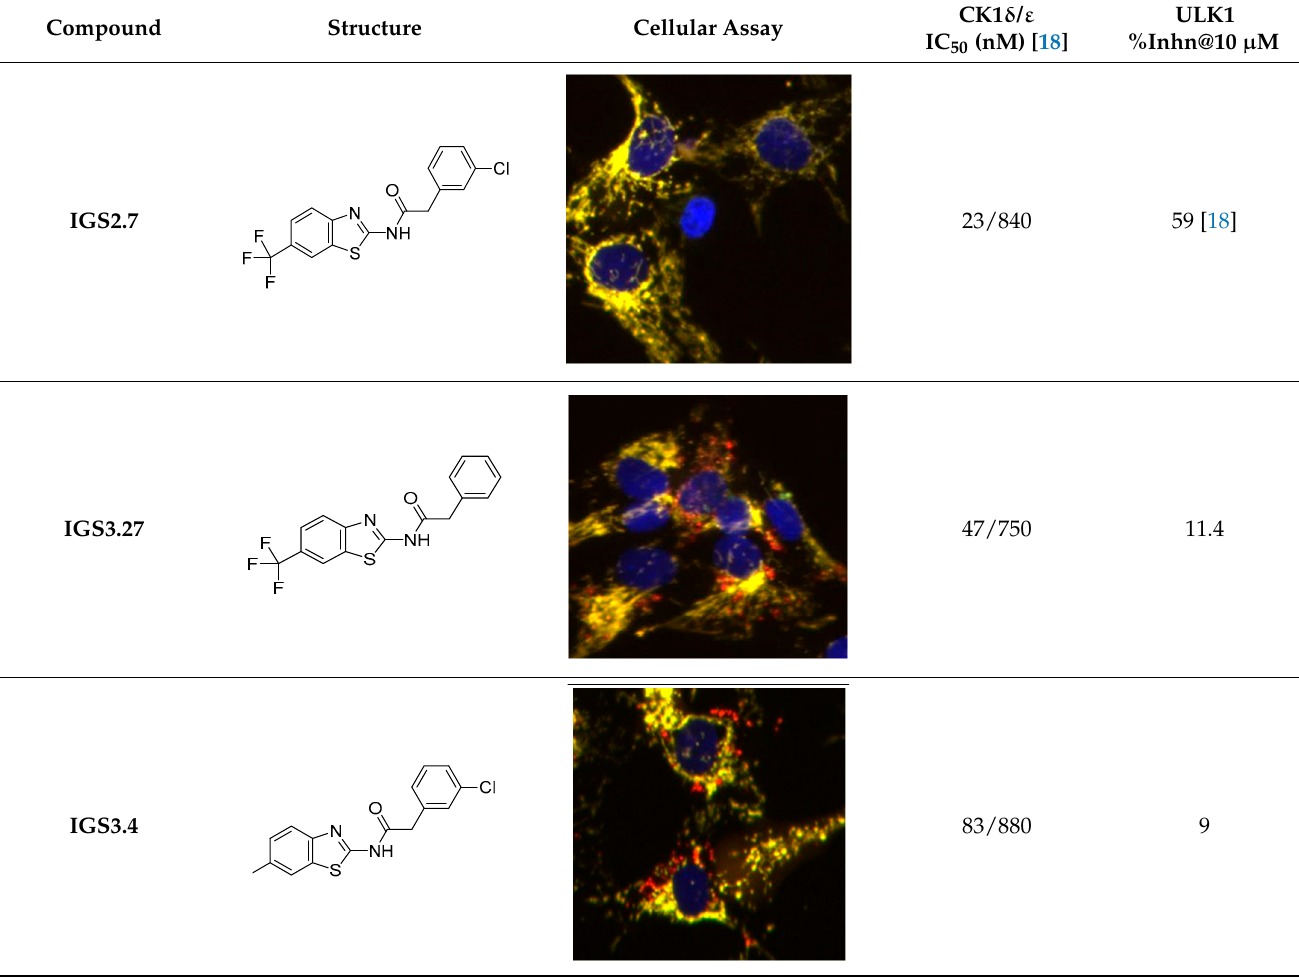
Table 1. Chemical structures of CK1 inhibitors included in the screening phase, their IC 50 against CK1 δ / ε , and the percentage of activity of the kinase ULK1.